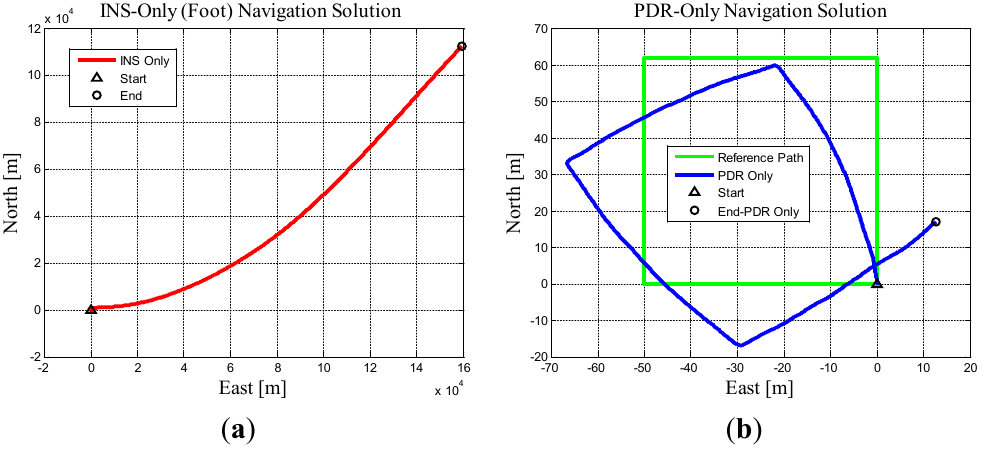
Figure 3. ( a ) INS Only navigation solution (from Inertial Navigation System/Zero Velocity